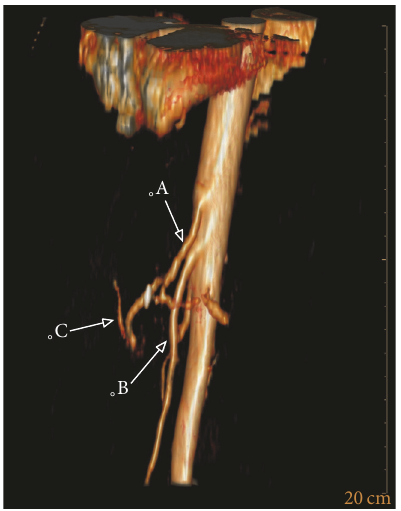
Figure 4: 3D reconstruction of the abdominal arteries showing the rareficationoftheperipheralhepaticarteries.(A)Truncuscoeliacus. (B) A. mesenterica sup. (C) Branch of the constricted hepatic